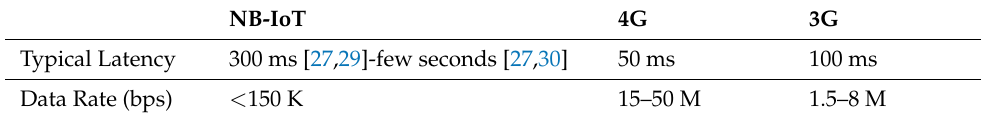
Table 7. Characteristics of 3GPP standardized wireless technologies used in the